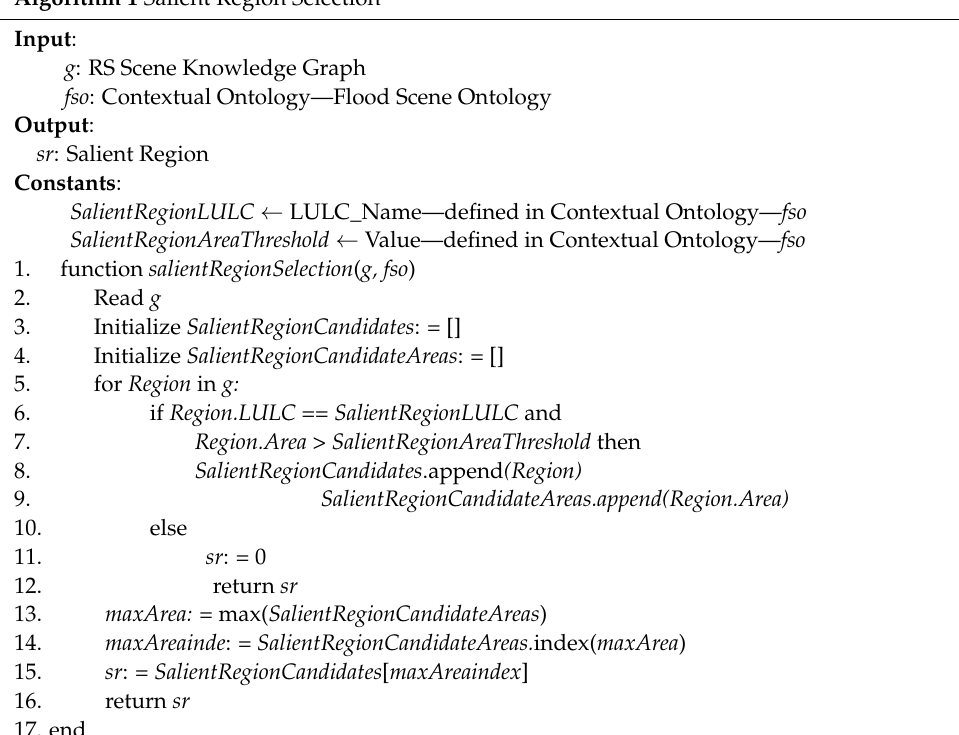
Algorithm 1 Salient Region Selection